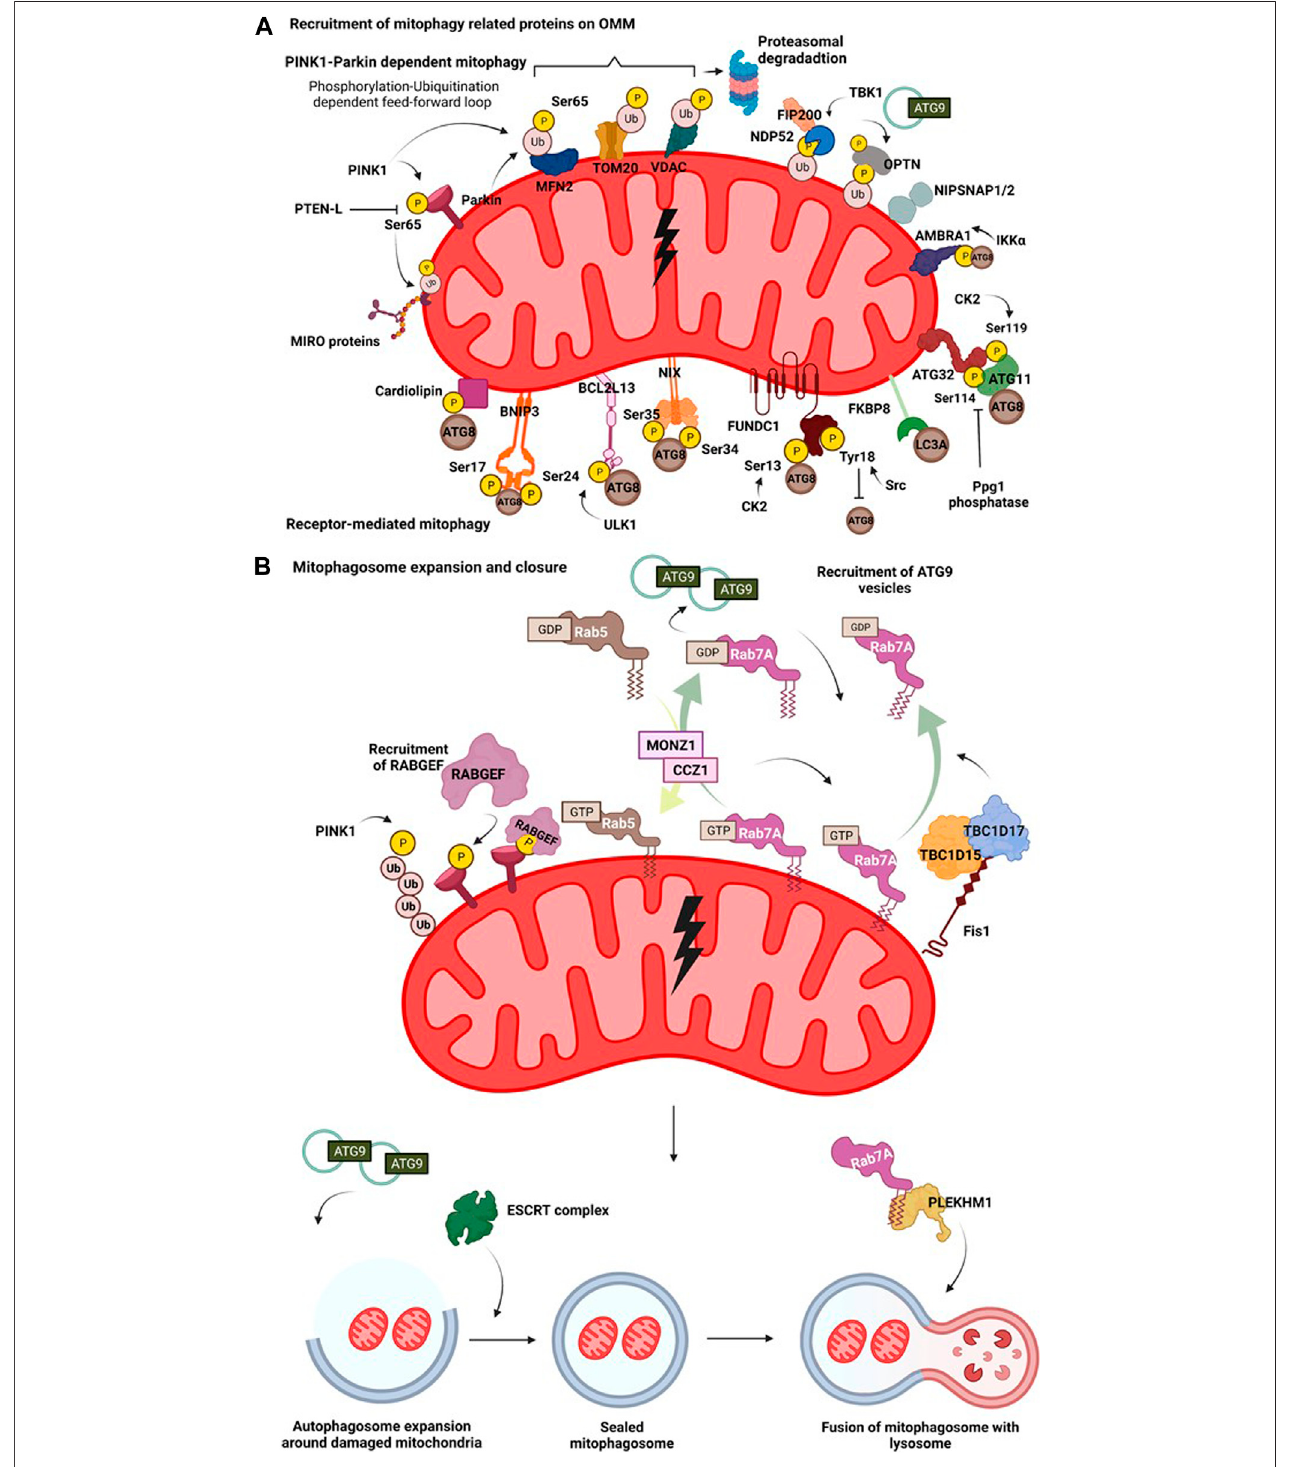
FIGURE 2 | Mitophagy pathway. (A) Recruitment of mitophagy related proteins on OMM . On mitochondrial insult, the damaged part of the mitochondrial network undergoes autophagy mediated degradation. A damaged mitochondria recruits several proteins on their surface that interact with the autophagy machinery in receptordependent orPINK1-Parkin dependentmanner.HypoxiainducesrecruitmentofBNIP3whichuponphosphorylationat itsSer17andSer24interactswithAtg8 family of proteins. Nix interacts with LC3 upon phosphorylation at its Ser34 and Ser35 positions. FUNDC1 interacts with the autophagy proteins and this is regulatedbyphosphorylationeventsatSer13byCK2andTyr18bySrckinase.FKBP8selectivelyinteracts withLC3A.Mitochondrialdamageresultsinphosphorylation